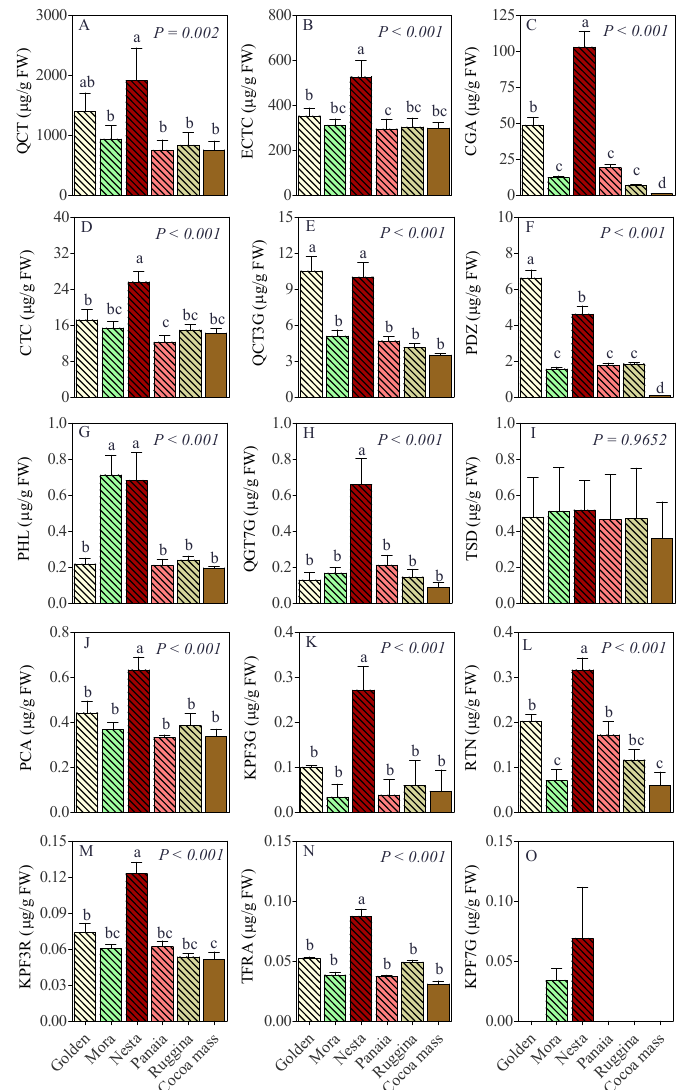
Figure 2. Mean values and standard deviation of ( A ) quercetin (QCT), ( B ) ( − )-epicatechin (ECTC), ( C ) chlorogenic acid (CGA), ( D ) (+)-catechin (CTC), ( E ) quercetin 3- O -glucoside (QCT3G), ( F ) phloridzin (PDZ), ( G ) Phloretin (PHL), ( H ) quercetagetin 7- O -glucoside (QGT7G), ( I ) tiliroside (TSD), ( J ) p -coumaric acid (PCA), ( K ) kaempferol 3- O -glucoside (KPF3G), ( L ) rutin (RTN), ( M ) kaempferol 3- O -rutinoside (KPF3R), ( N ) trans -ferulic acid (TFRA), and ( O ) kaempferol 7- O -glucoside (KPF7G), expressed as µ g/g FW for cocoa bars and cocoa mass determined by UHPLC-ESI-MS/MS. Data ( n = 3) were analyzed by one-way ANOVA. Different letters are significantly different according to Tukey’s post-hoc test at the 0.05 probability level.